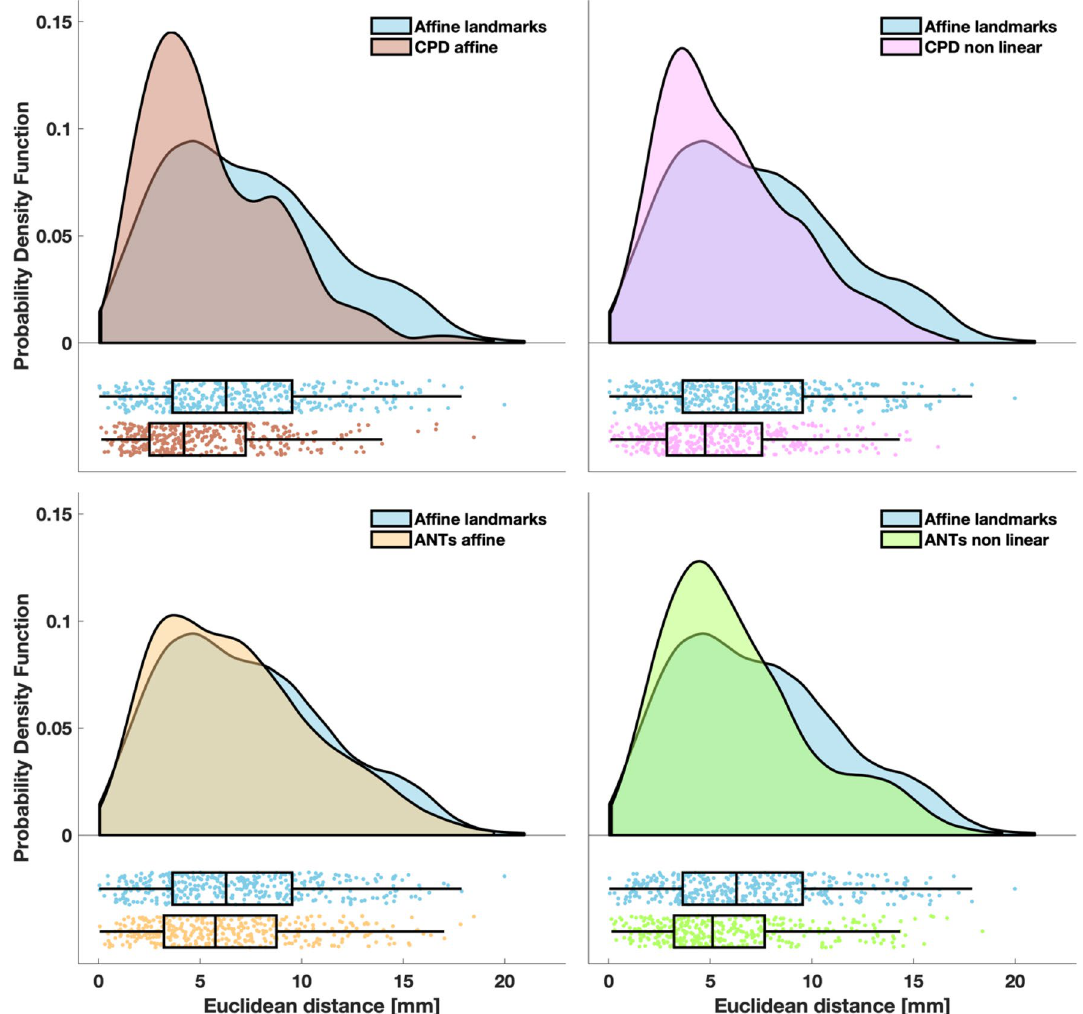
Figure 6. Euclidean distance between the benchmarks of the location of the peak of the fluence distribution and the location of the peak of the registered fluence distributions. The probability density function of the localization errors obtained with CPD affine (top left panel), CPD non linear (top right panel), ANTs affine (bottom left panel) and ANTs non linear (bottom right panel) are superimposed to probability density function of the localization errors obtained with the affine transformation based on landmarks. In the lower part of each panel, the same data are presented as a box plot. Left and right edges of the box indicate the 25th and 75th percentile, whereas the central mark indicates the median. The whiskers extend to the most extreme data value not considered an outlier. Each dot represents a sensor of a participant. Probability density functions were estimated with the kernel density estimation method and graphs were generated as described in Allen et al. 65